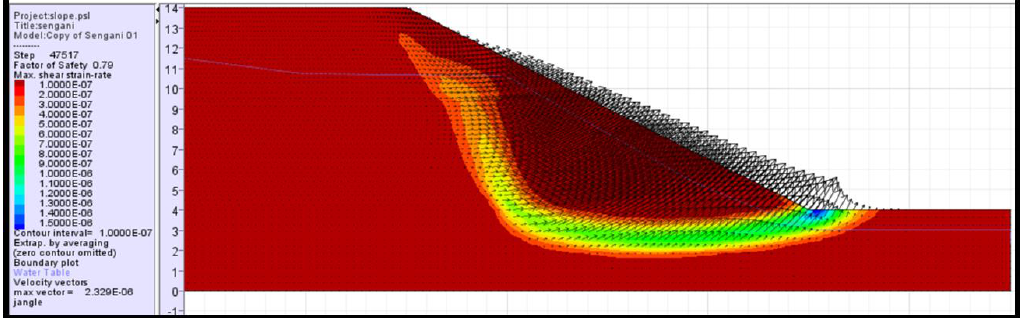
Figure 18. Simulated FoS of the clay soil slope using FLACSlope in rainy conditions with water table with 2500 m 3 of water. Note that maximum shear strain simulated ranges between 1.0 × 10 − 7 to 2.329 × 10 − 6 .